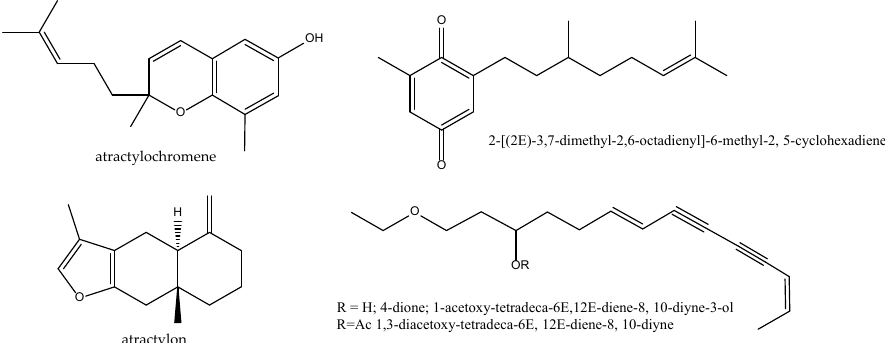
Figure 6. Bioactive anti-inflammatory (eicosanoid inhibition) and antioxidant principles from Atratylodes macrocephala.